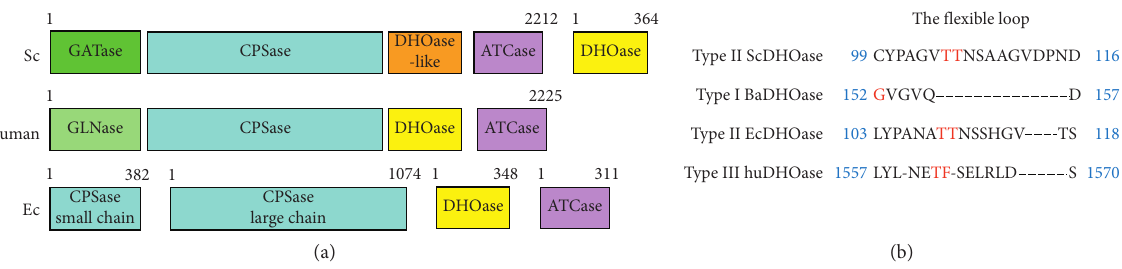
Figure 1: Comparison of DHOases. (a) The gene products for the first three reactions of pyrimidine biosynthesis are different among species. The higher eukaryotic human CAD consists of DHOase, CPSase, and ATCase domains fused covalently. Bacterial DHOase, CPSase, and ATCase function separately. However, CPSase and ATCase activities in S. cerevisiae are present in a single bifunctional protein, Ura2. Ura2 is a CAD-like polypeptide that contains a defective DHOase-like domain. (b) Sequence alignment of the flexible loop. The amino acids that are involved in catalysis are in red. The sequence composition and the length of these flexible loops are significantly